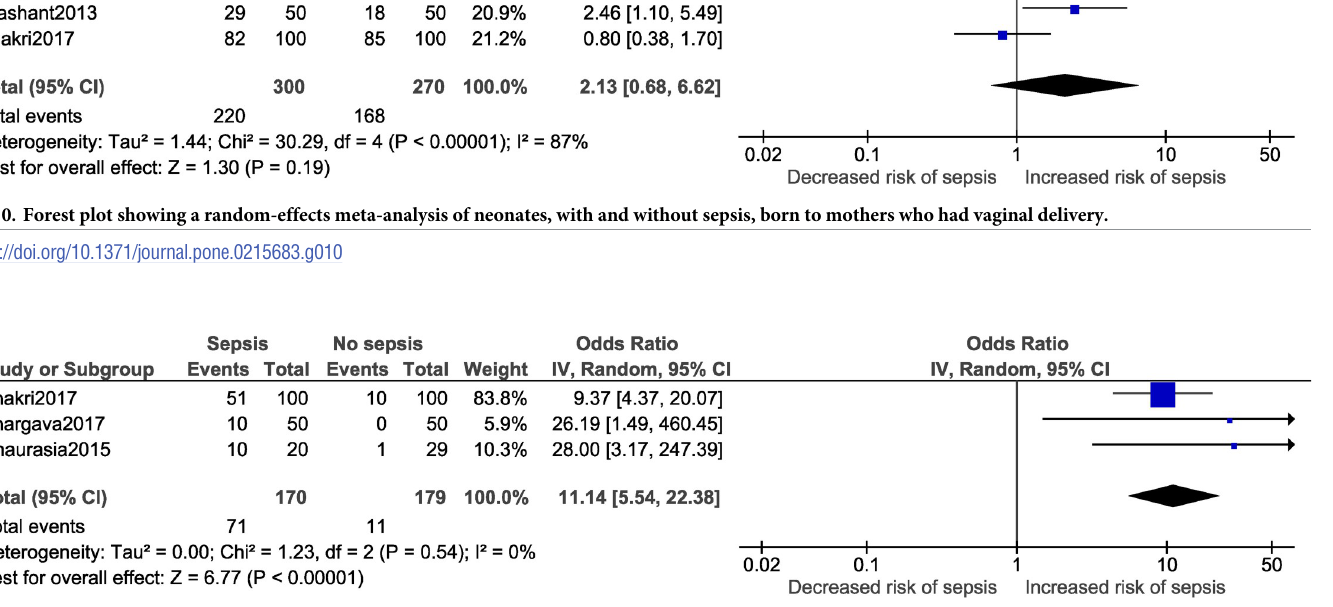
Fig 11. Forest plot showing a random-effects meta-analysis of neonates, with and without sepsis, born to mothers with premature rupture of membranes.